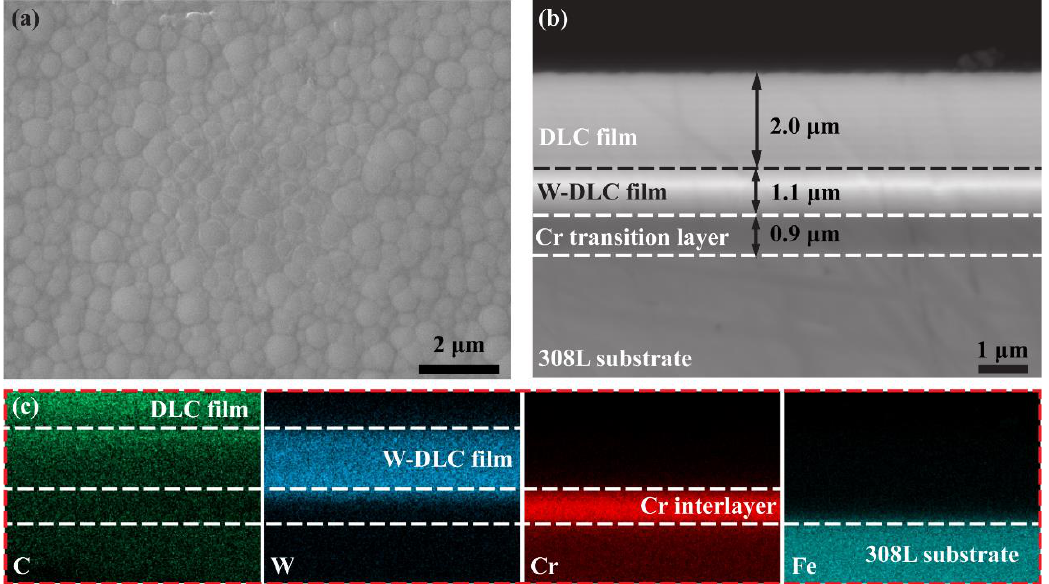
Figure 2. SEM micrographs and EDS analysis results of the surface and cross-section of Cr/W- DLC/DLC multilayers: ( a ) Surface topography; ( b ) cross-sectional topography; ( c ) EDS mapping of the cross-section.